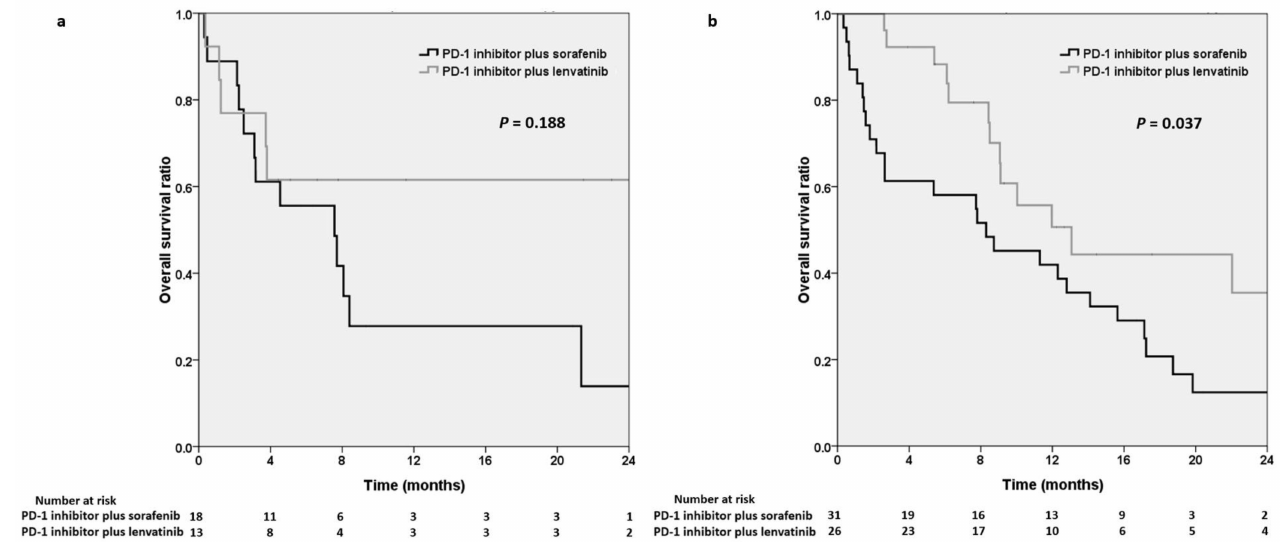
Figure 4. Kaplan–Meier analysis demonstrating overall survival in the PD-1 inhibitors plus sorafenib group and the PD-1 inhibitors plus lenvatinib group in patients receiving combination therapy as first-line treatment ( a ) and as second- or further-line treatment ( b ), respectively. PD-1, programmed cell death protein-1; MTKI, multitarget tyrosine kinase inhibitor.